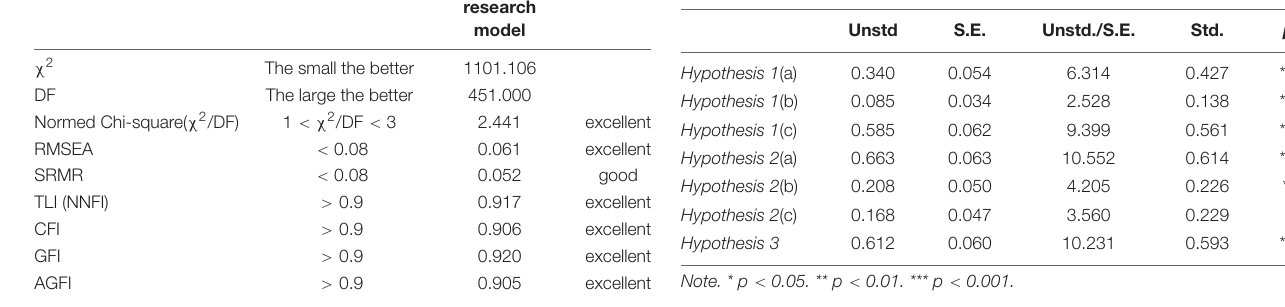
TABLE 3 | Model fit criteria and the test results. Model fit TABLE 4 | Regression